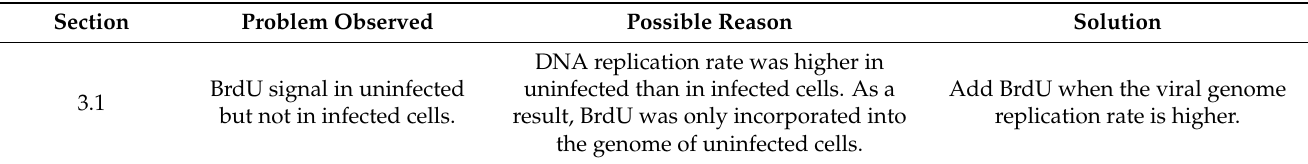
Table 2. Troubleshooting table for BrdU of labeling adenovirus genomes in the